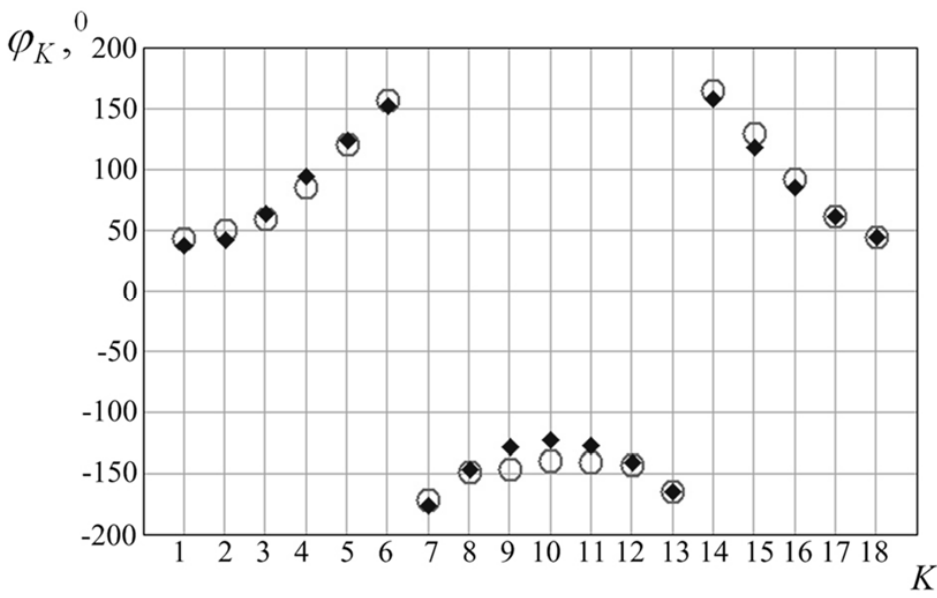
Figure 24. The phase values at points on the radius R 1 = 45 mm at f = 1800 MHz.